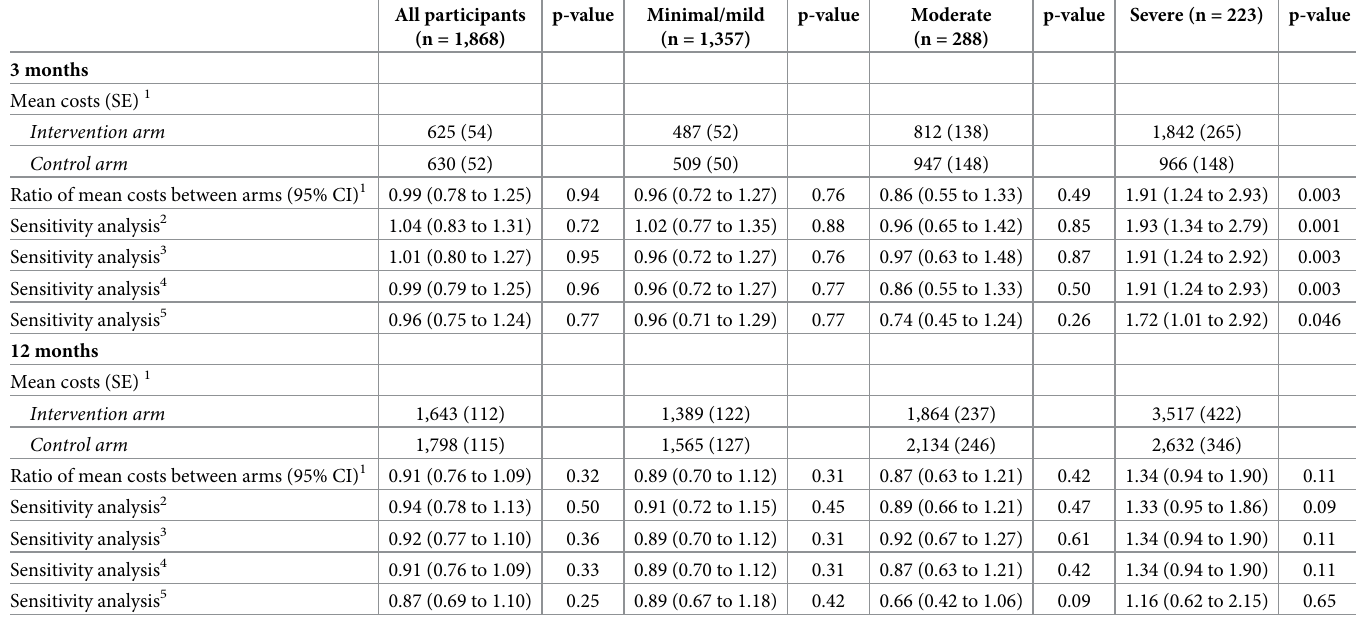
Table 1. Comparison of health sector costs by trial arm, across all participants and stratified by prognostic group (multiple imputed data).